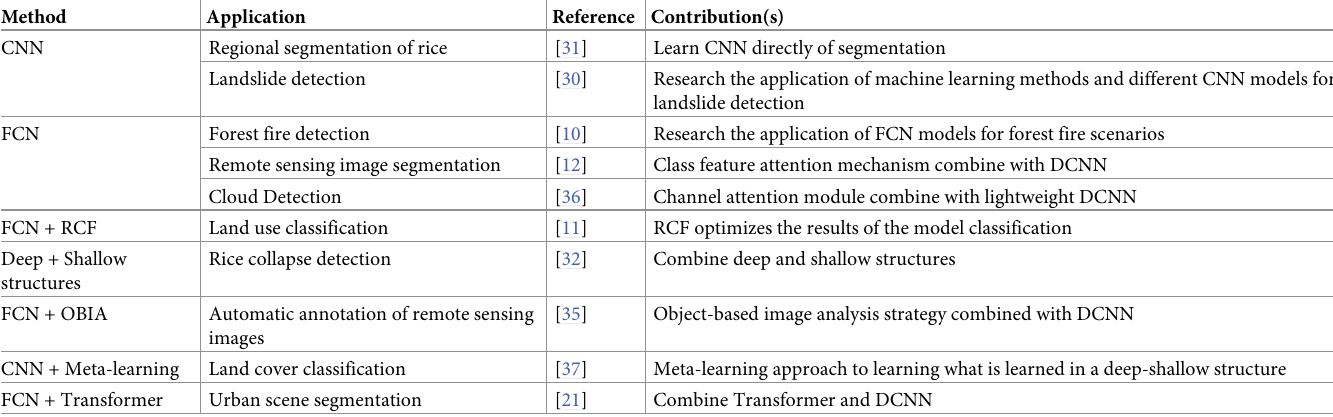
Table 1. Summary of remote sensing image segmentation methods based on